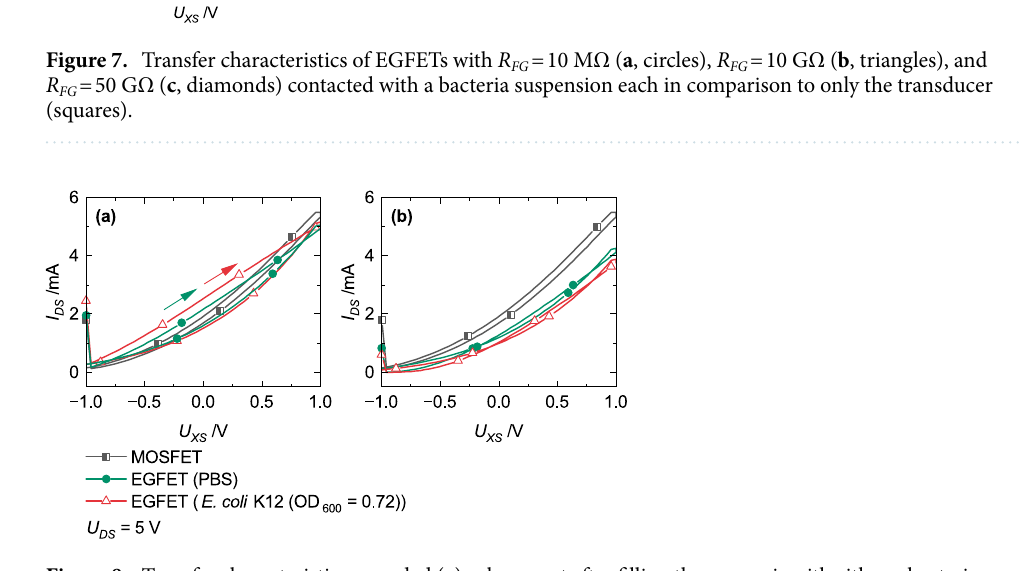
Figure 8. Transfer characteristics recorded ( a ) subsequent after filling the reservoir with either a bacteria suspension or a PBS-solution and ( b ) after application of a constant voltage of U DS = 5 V and U CS = 1 V on the EGFET. Circles represent the measurement with a bacteria suspension, triangles with a PBS-solution, and squares represent the transfer characteristic of the